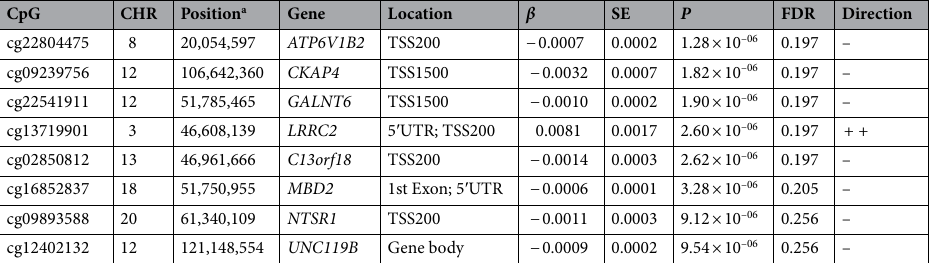
Table 3. Top differentially methylated positions from EWAS meta-analysis of left-handedness. β is the regression coefficient for left-handedness in EWAS meta-analysis adjusted model that included N NTR adults = 2663 and N ALSPAC adults = 1058. CpGs with uncorrected P -value < 1.0 × 10 –5 are presented. CHR chromosome; SE standard error; FDR false discovery rate; TSS200 200 base pairs upstream of transcription start site; TSS1500 1500 base pairs upstream of transcription start site; 5 ′ UTR 5 ′ untranslated region; + +, positive direction of effect in each cohort; –, negative direction of effect in each cohort. a Genome build Hg19 (build 37). See additional information on CpGs in Supplementary Table 12.